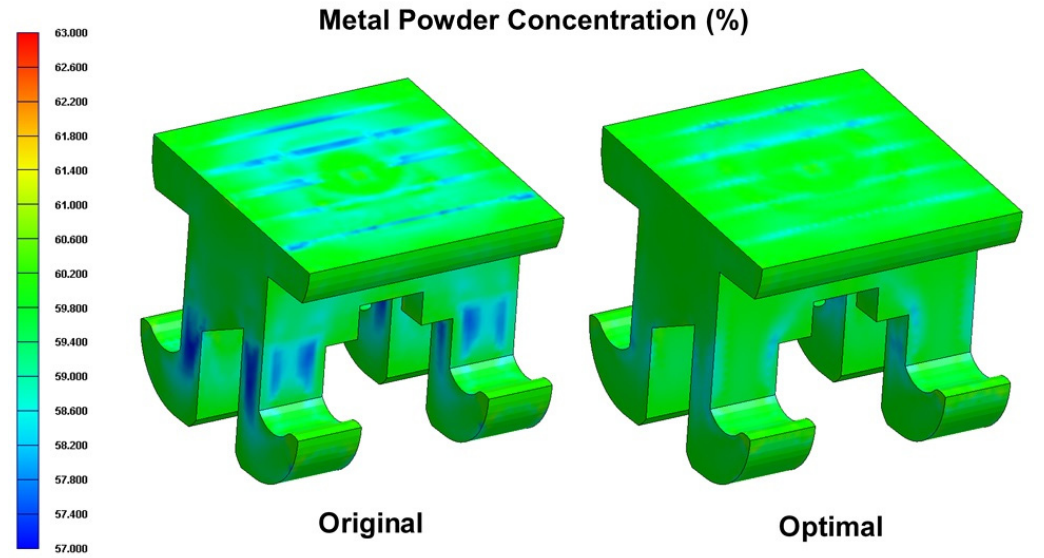
Figure 14. Comparison of metal powder concentration distributions on surface of orthodontic brace in original process design and optimal process design.